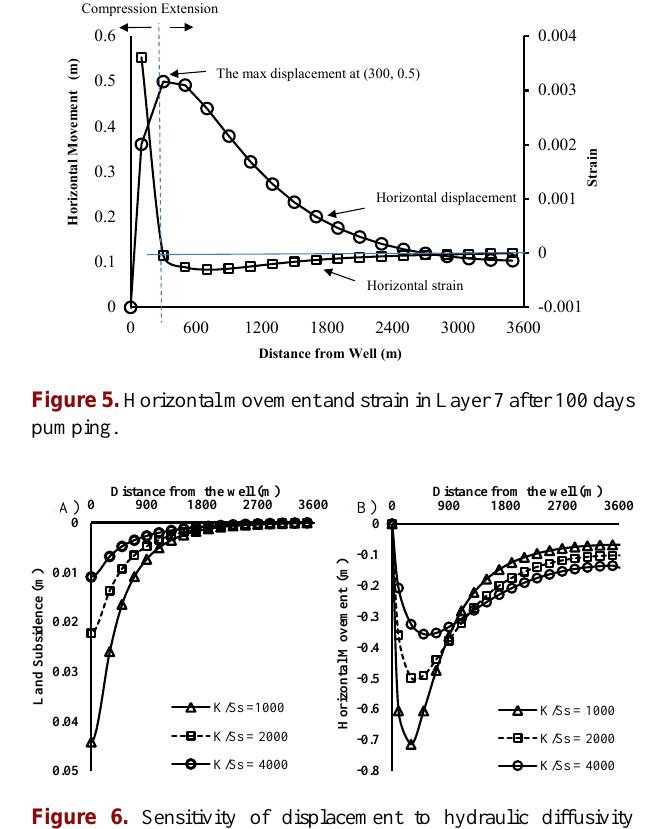
Figure 6. Sensitivity of displacement to hydraulic diffusivity (m 2 /day) using the NDIS model (a) Subsidence, (b) Horizontal movement (Layer 7) after 100 days pumping.